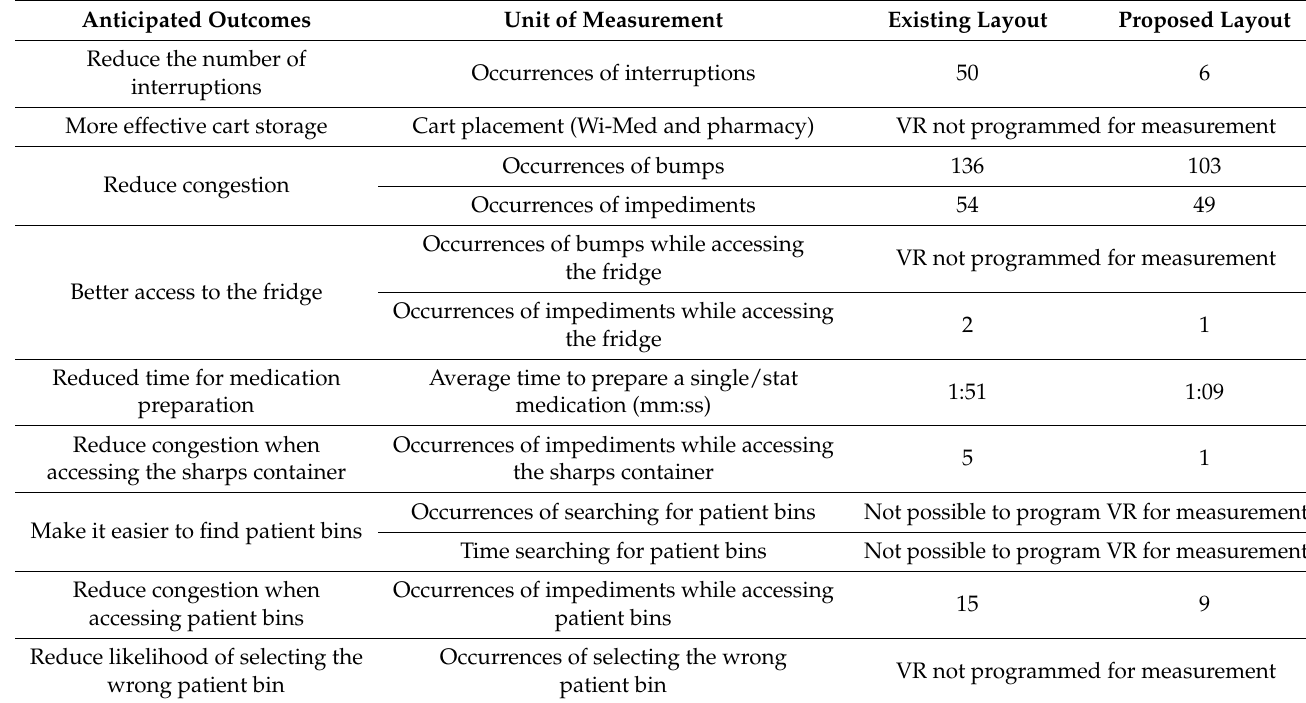
Table 5. Comparison of anticipated outcomes between the existing and proposed layout based on data collected through the VR mock-up